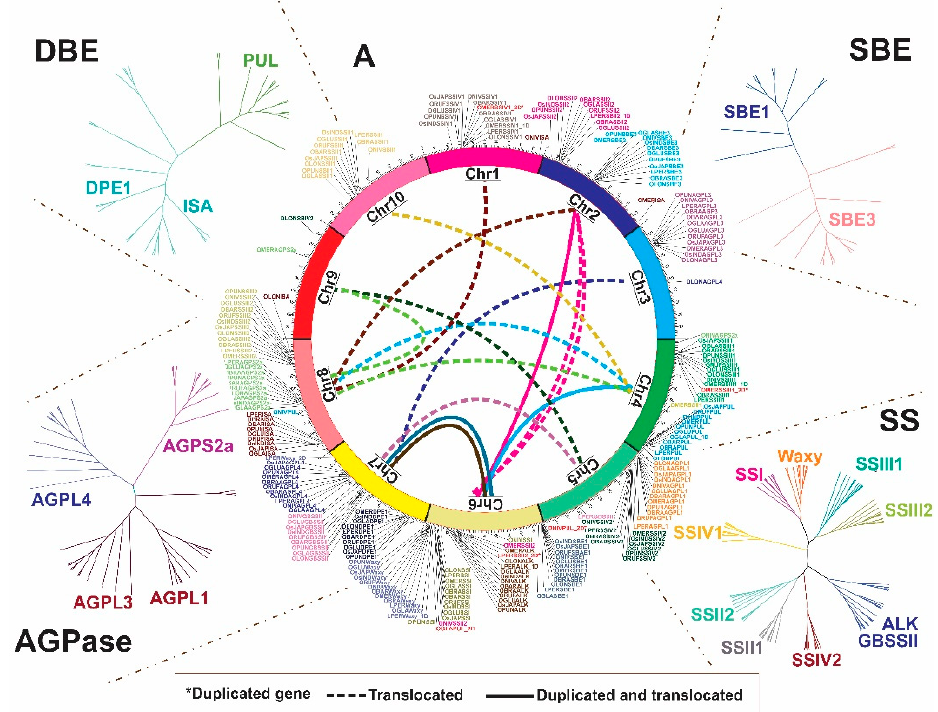
Figure 1. Gene localization and phylogeny of SSR proteins . Center. Circular map of SSRGs in a single representation from chromosomes 1 to 10 in Oryza species. Duplicated genes are marked with an asterisk. Around the map. Phylogenetic analysis of DBE (De ‐ branching enzymes) (represented by DPE1 (Disproportionating enzyme), ISA (Isoamylase), PUL (Pullulanase); SBE (Starch branching enzymes) (represented by SBE1 and SBE3); SS (Starch synthase) (represented by SSI, SSII1, SSII2, ALK (Starch synthase II ‐ 3), SSIII1, SSIII2, SSIV1, SSIV2, Waxy (Granule ‐ bound starch synthase I), GBSSII (Granule ‐ bound starch synthase II); and AGPase proteins. Clade groups are indicated by different colors followed by the name.